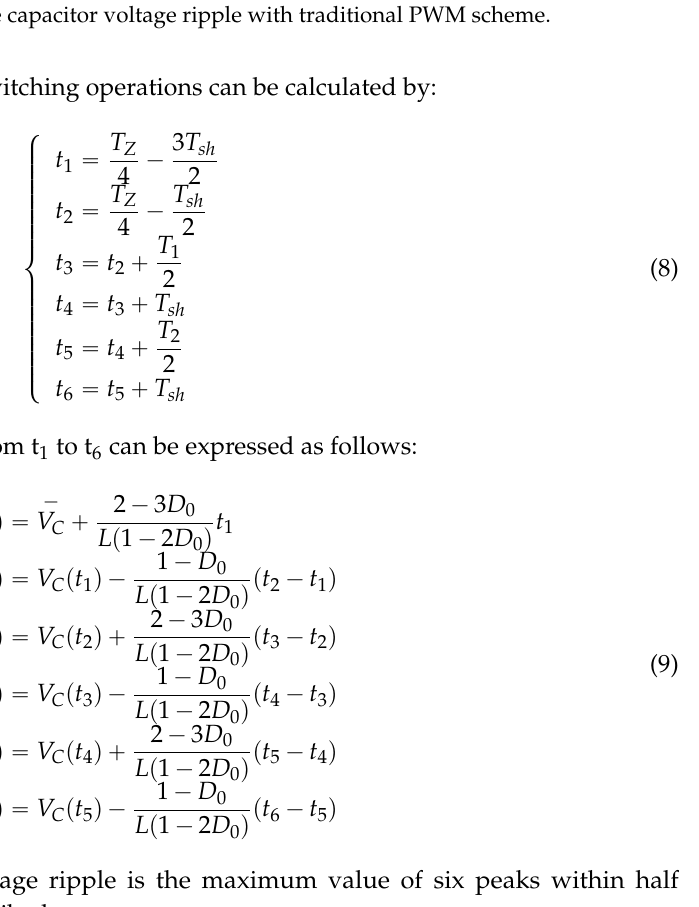
Figure 5. Diagram of Z-source capacitor voltage ripple with traditional PWM